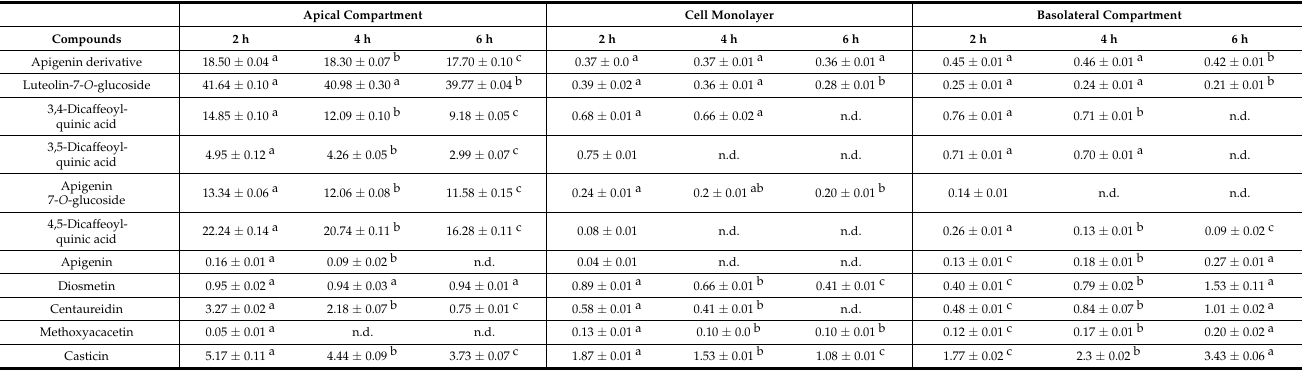
a,b,c Different letters denote statistical differences within a line according to Fisher’s least significant difference (LSD) procedure ( p < 0.05). n.d.: not